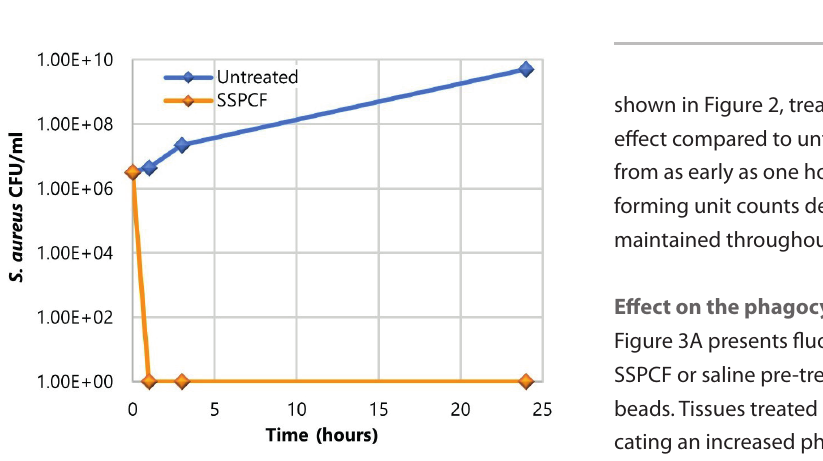
Figure 2. Efficacy of SSPCF against S. aureus growth. Chart shows the bacterial growth in suspensions incubated with or without (growth control) 1% of SSPCF at 0h (incubation start point), 1h, 3h and 24h post